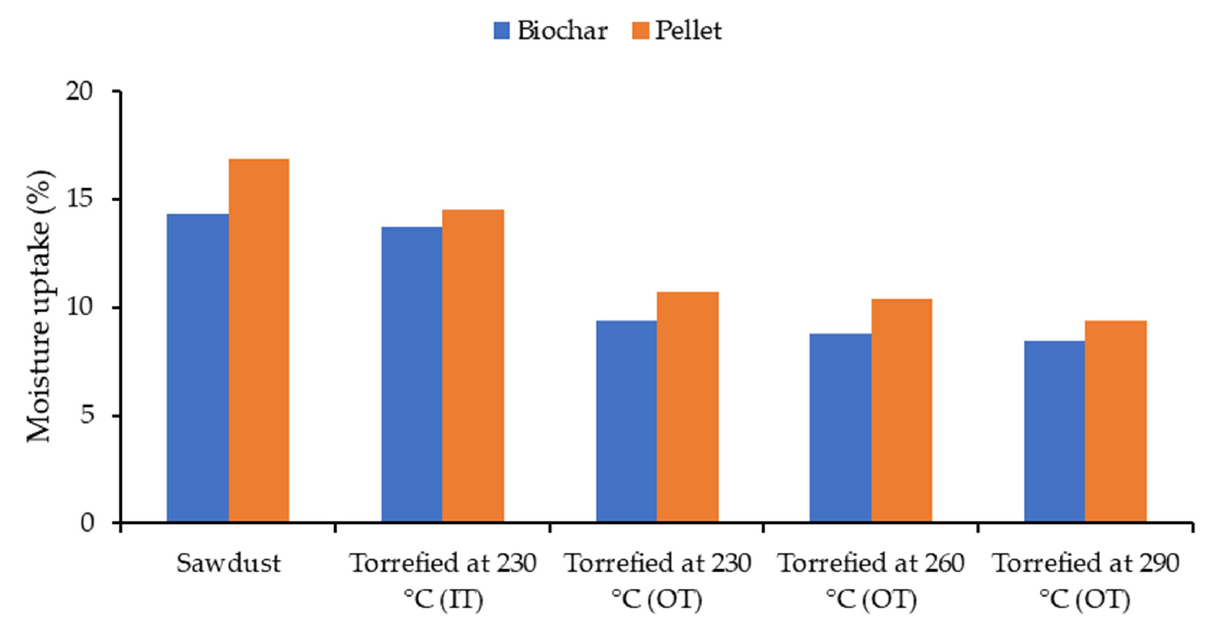
Figure 9. Moisture uptake of torrefied sawdust and resultant pellets with 20% steam-treated binder; IT: inside temperature, OT: outside temperature.